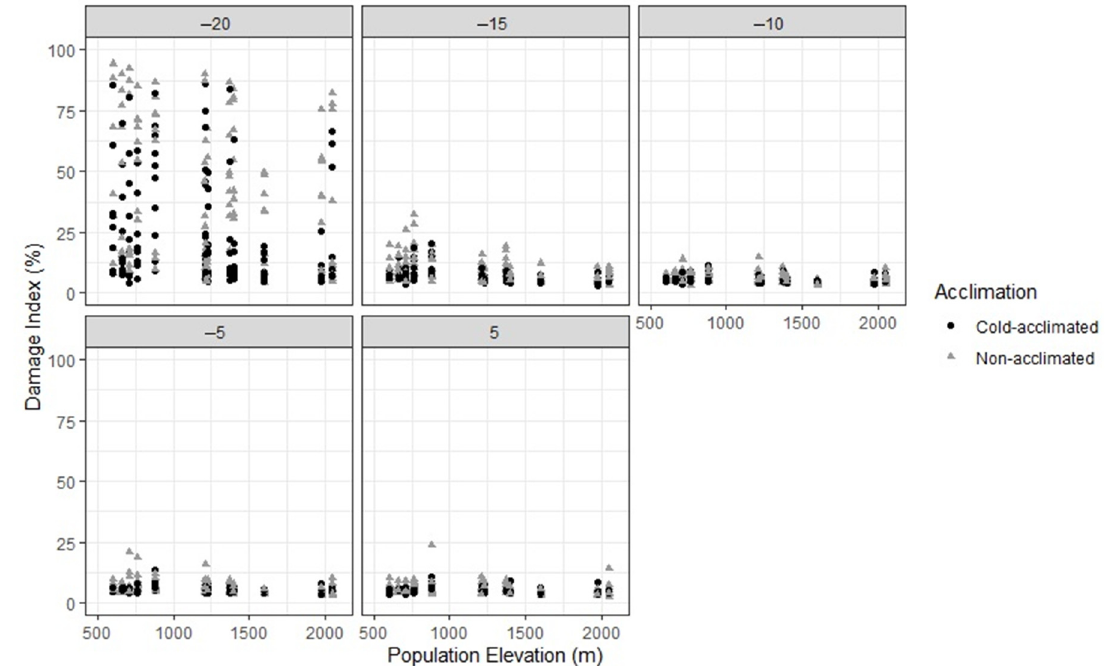
Figure 5. Comparison of damage index (%) of cold-acclimated and non-acclimated koa leaf samples. Results at each test temperature (5, − 5, − 10, − 15, and − 20 °C) are pooled across all population elevations.